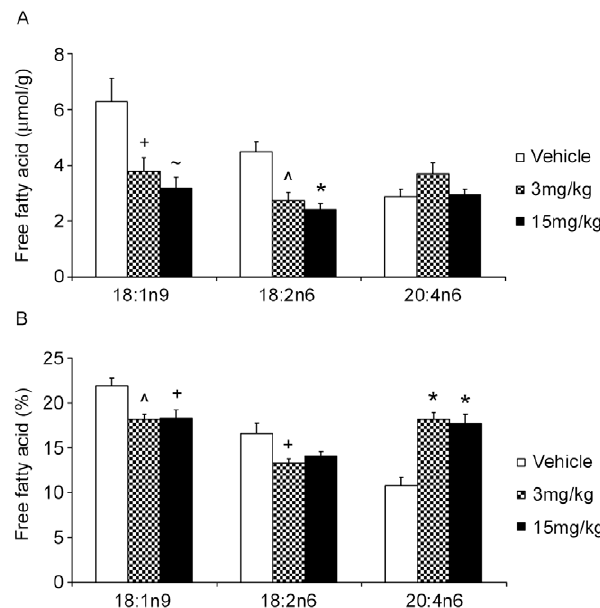
Figure 6. Results from lipomics analysis showing effect of PF- 04620110 on tissue levels of two of the most abundant free fatty acids: Oleic 18:1n9 and Arachidonic acid 20:4n6 in rat jejunum. Represented in raw values (umol/g tissue, panel A) and normalized values (% of total free fatty acids, panel B). Symbols indicate significance from vehicle with P value thresholds of , 0.001 (*), , 0.005 (ˆ), , 0.01 ( , ), , 0.05 ( + ) for n = 8 rats per treatment group.